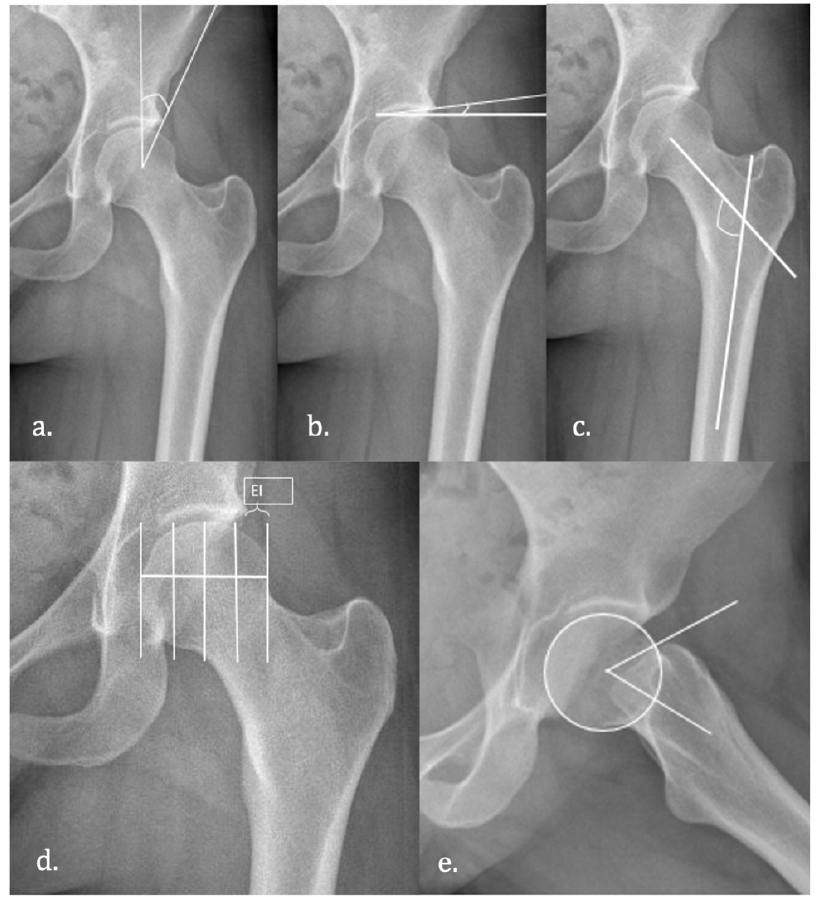
Figure 2. Hip angles. ( a ) Wiberg angle; ( b ) Tönnis angle; ( c ) centrum–collum–diaphyseal angle ( d ) extrusion index and ( e ) alpha angle. ( d ) extrusion index and ( e ) alpha